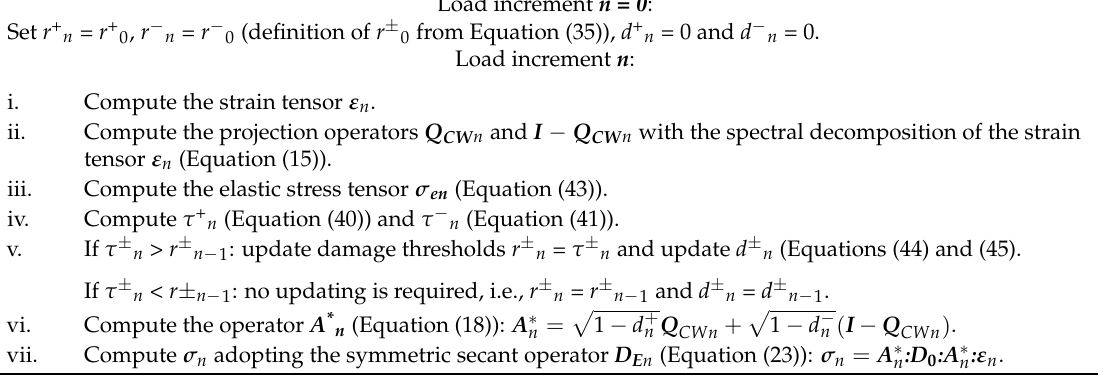
Table 1. Algorithm for the d + / d − damage model based on energy equivalence. Load increment n = 0